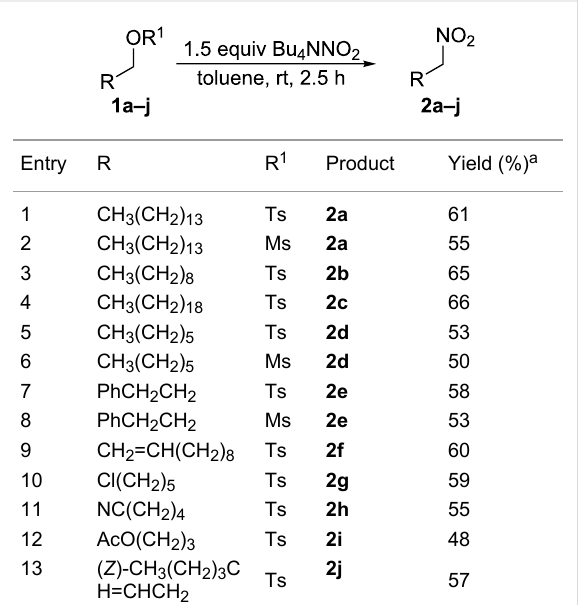
Table 2: Synthesis of primary nitroalkanes 2a–j